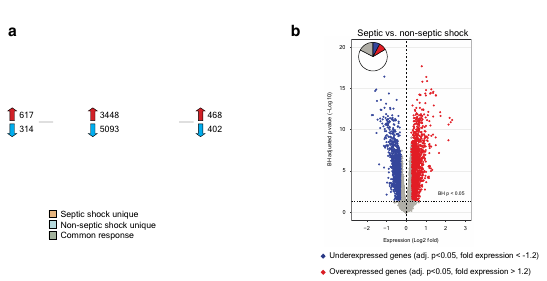
Fig. 1 Hepatic injuries for 2009 and 2017 Dengue